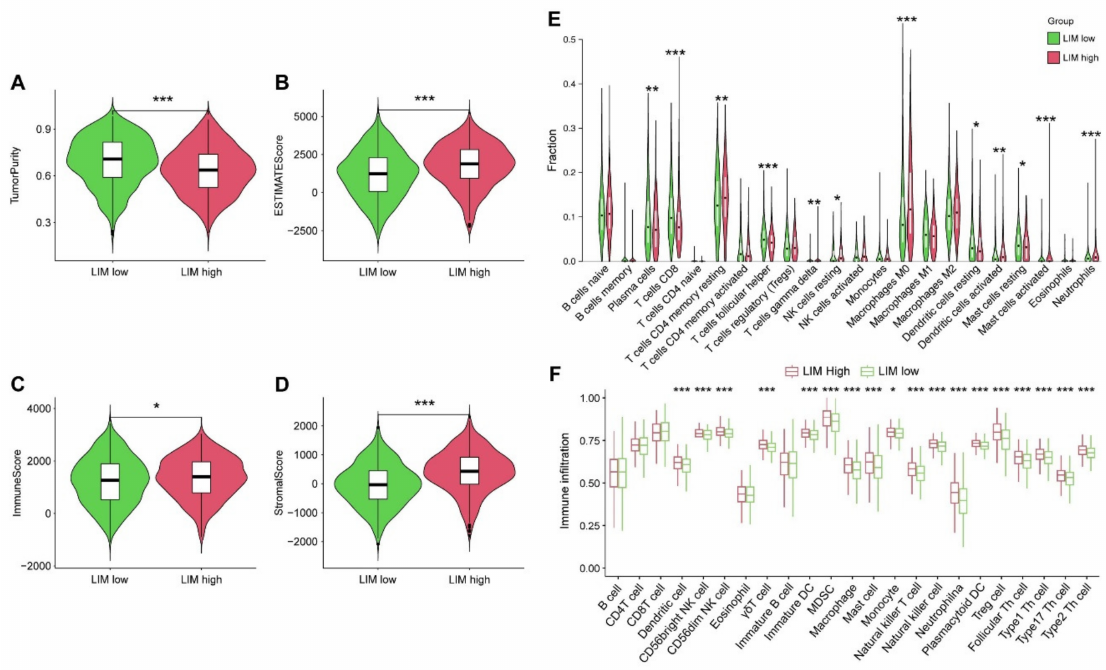
Figure 3. Tumor microenvironment (TME) characteristics of the LIM-high and the LIM-low groups. ( A – D ) The tumor purity, estimate score, immune score, and stromal score in the LIM-high and the LIM-low groups. The levels of TME infiltrating immune cells in the LIM-low and the LIM-high groups using cibersort ( E ) and ssGSVA algorithm ( F ). * p < 0.05; ** p < 0.01; *** p <